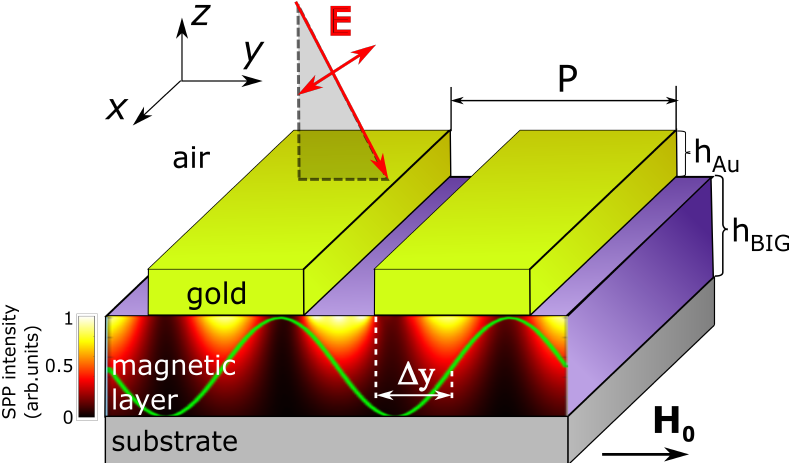
Figure 2. The scheme of the addressed magnetoplasmonic nanostructure. Gold grating is fabricated above the ferrimagnetic layer magnetized by the external magnetic field H 0 directed along the y -axis. The spin wave also propagating along the y -axis creates a modulation of the magnetization inside the magnetic layer shown by the green line. This leads to modulation of the gyration value g x along the y -axis (green curve). The nanostructure is illuminated by linearly p -polarized light (shown by the red oblique arrow) with the plane wavefront. The electric vector E of the input light lies in the plane zOy . The spatial distribution of the intensity of the optical field inside the ferrimagnetic layer related to the excitation of the SPP wave is shown by a yellow-red-black color plot. One can see that the period of the magnetization modulation is equal to double the period of the SPP wave. Parameter ∆ y is a spatial shift between the left edge of the nearest gold stripe (the start of the plasmonic grating period) and ‘zero’ of the gyration modulation. This parameter plays a role in the phase shift between the optical mode and the magnetization modulation. The parameters h Au and h BIG refer to the thickness of gold and ferrimagnetic layers,